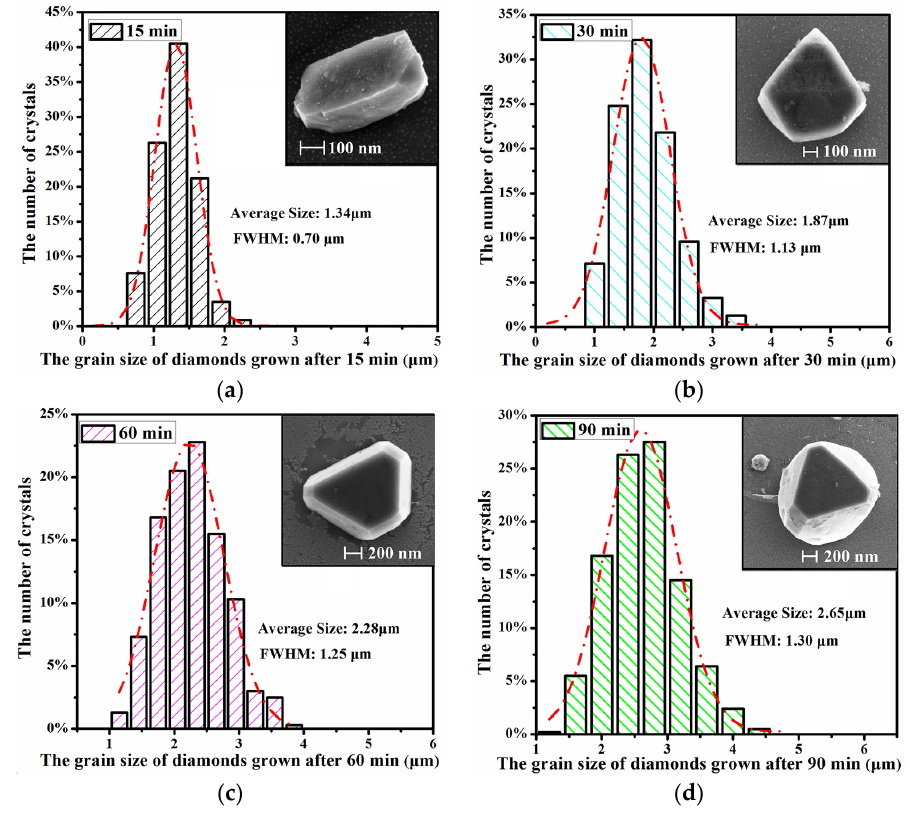
Figure 6. The grain size and size distribution of CVD microcrystalline diamonds at the growth duration of ( a ) 15 min, ( b ) 30 min, ( c ) 60 min, and ( d ) 90 min, and their FESEM micrographs under the identical conditions.